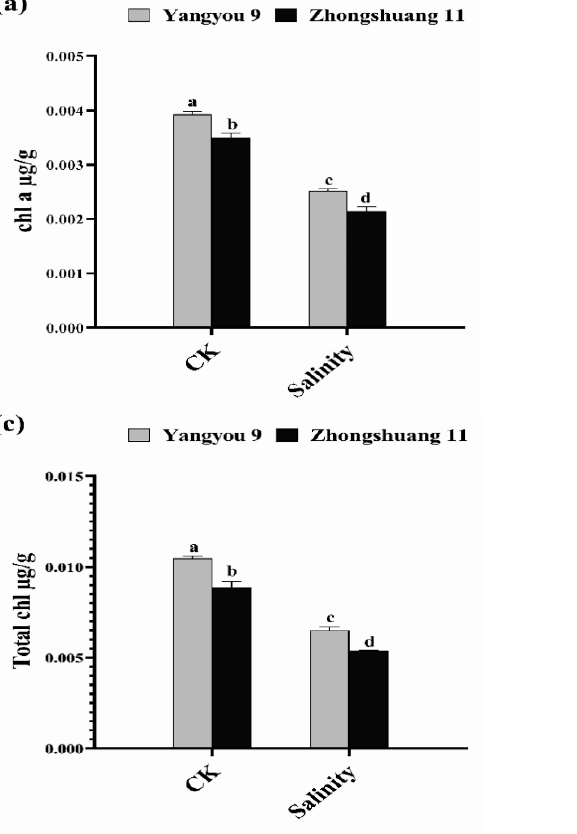
Figure 2. Modifications in ( a ) chlorophyll a, ( b ) chlorophyll b, ( c ) total chlorophyll, and ( d ) carotenoid content under normal and salt conditions induced by 150 mM NaCl. Bars represent ± SE of three replicates. Letters (a, b, c and d) on vertical bars represent significant differences between cultivars and treatments according to Duncan’s multiple range test (DMRT) at p <